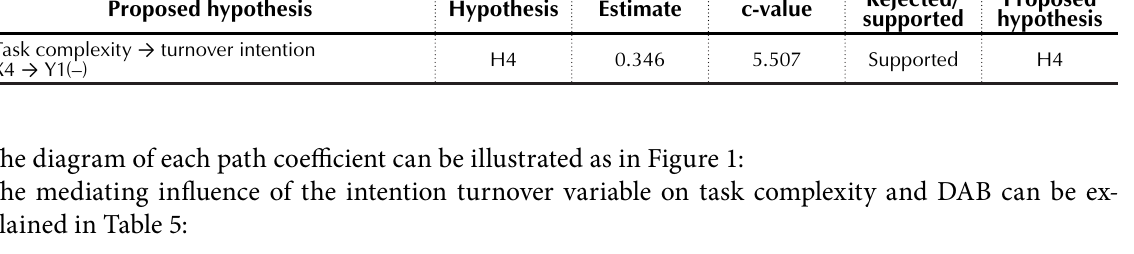
Table 5. Mediating variable detection